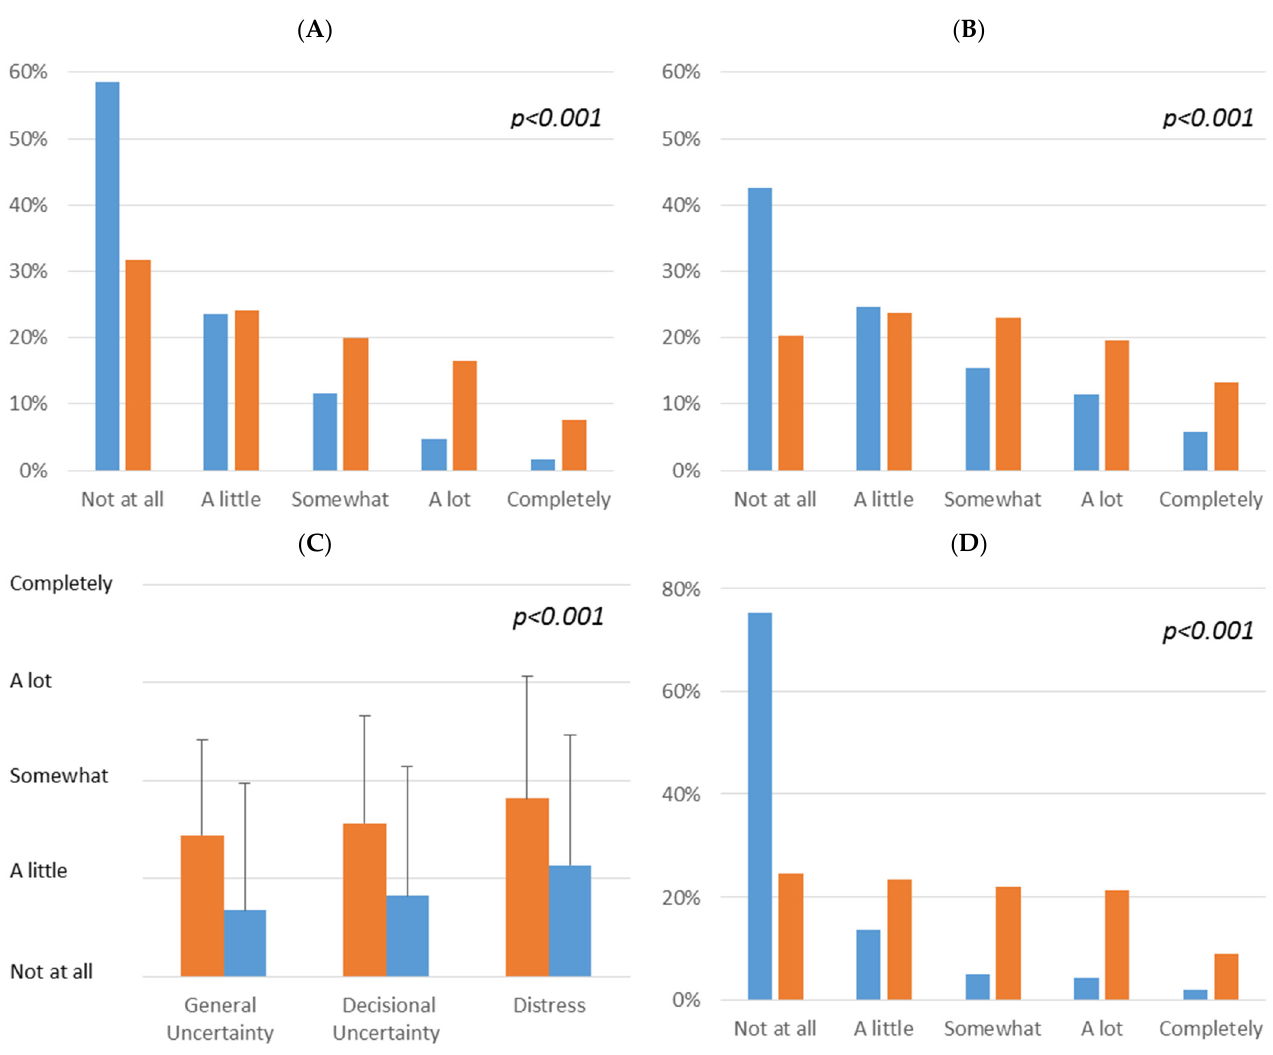
Figure 1. Perception of ( A ) decisional uncertainty and ( B ) distress due to uncertainty in oncology (blue) and psychiatry (orange) patients; ( C ) mean ± SD for general, treatment-related decisional uncertainty and resulting distress during own treatment decisions; ( D ) required treatment modification due to pandemic conditions from patients’ perspectives (Percentage histograms of all respondents).